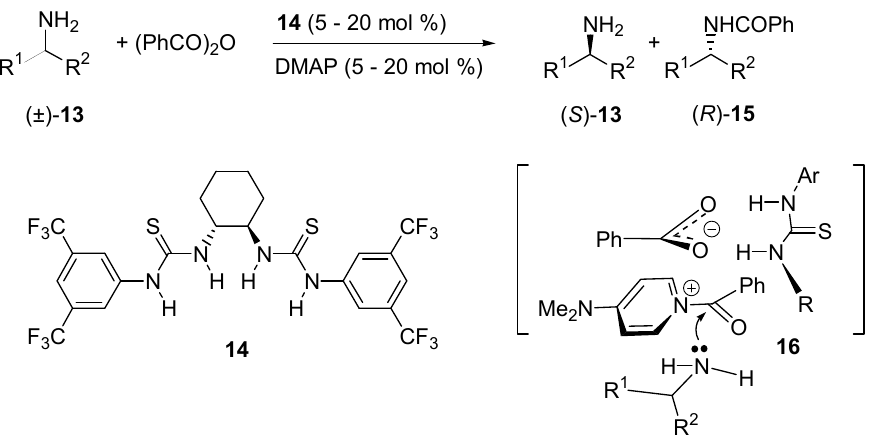
Scheme 10. Kinetic resolution of (±) ‐ 13 catalyzed by thiourea 14 .